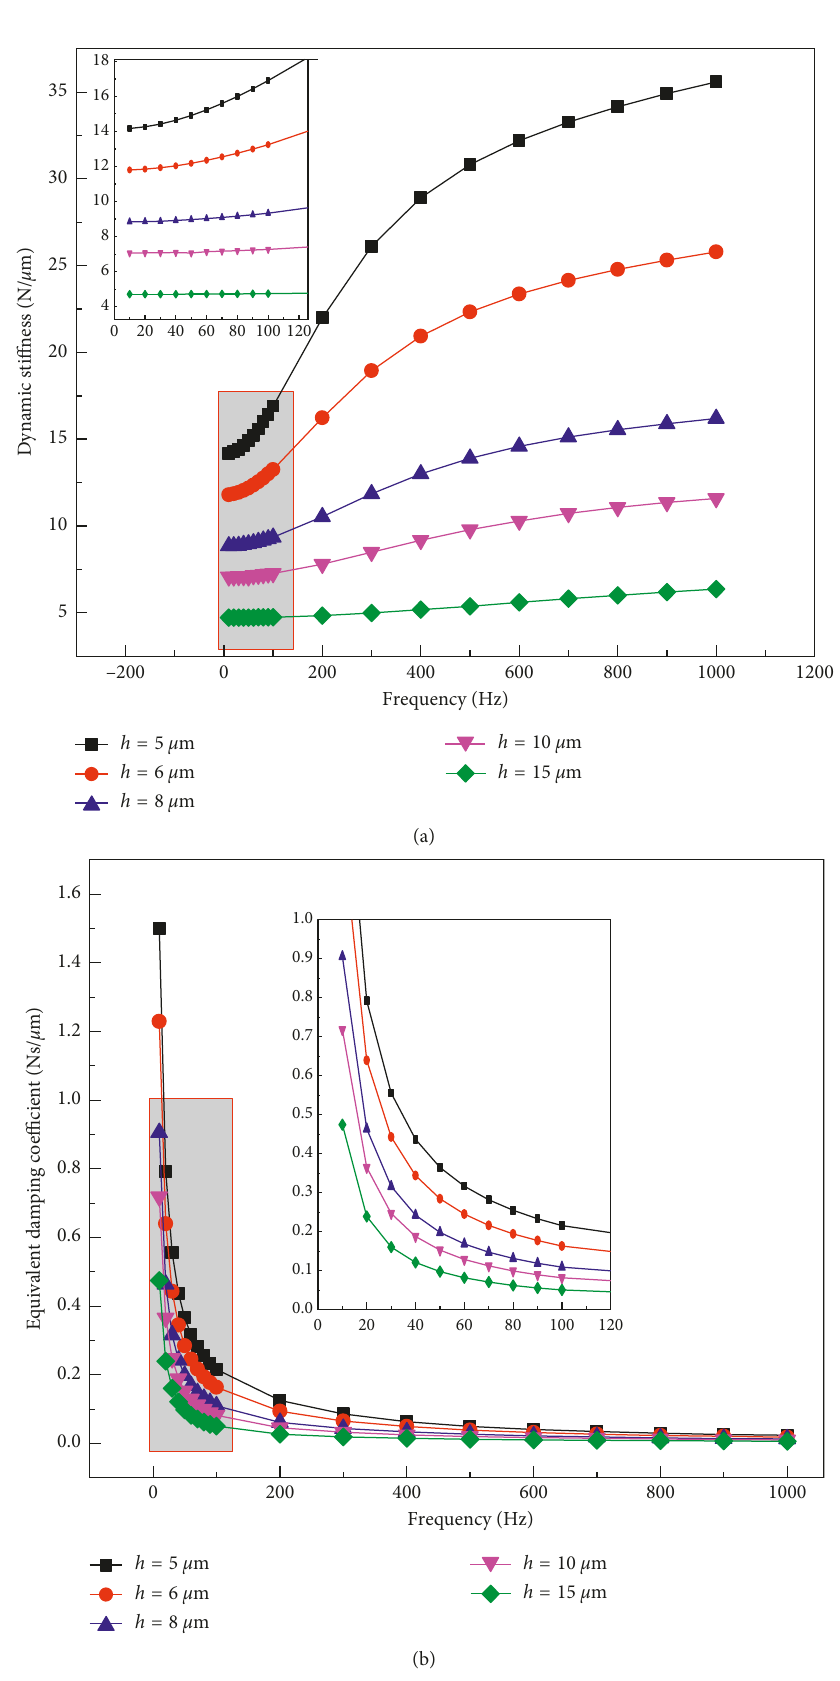
Figure 4: Influence of the perturbation frequency on dynamic characteristics of aerostatic bearings with EEPG. (a) Influence of the disturbance frequency on the dynamic stiffness. (b) Influence of the disturbance frequency on the equivalent damping